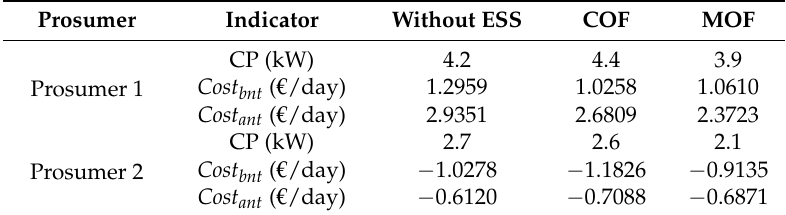
Table 3. Economic indicators for each of the prosumers with individual schedule.